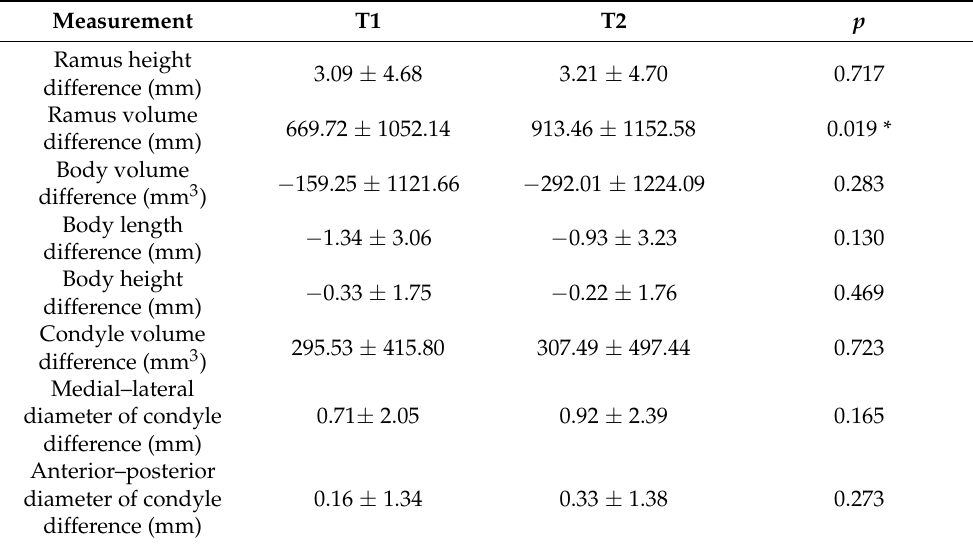
Table 6. Comparison of the difference between the two sides of the mandible within 2 weeks after surgery (T1) and at over 6 months after surgery (T2) in patients with asymmetric mandibu- lar